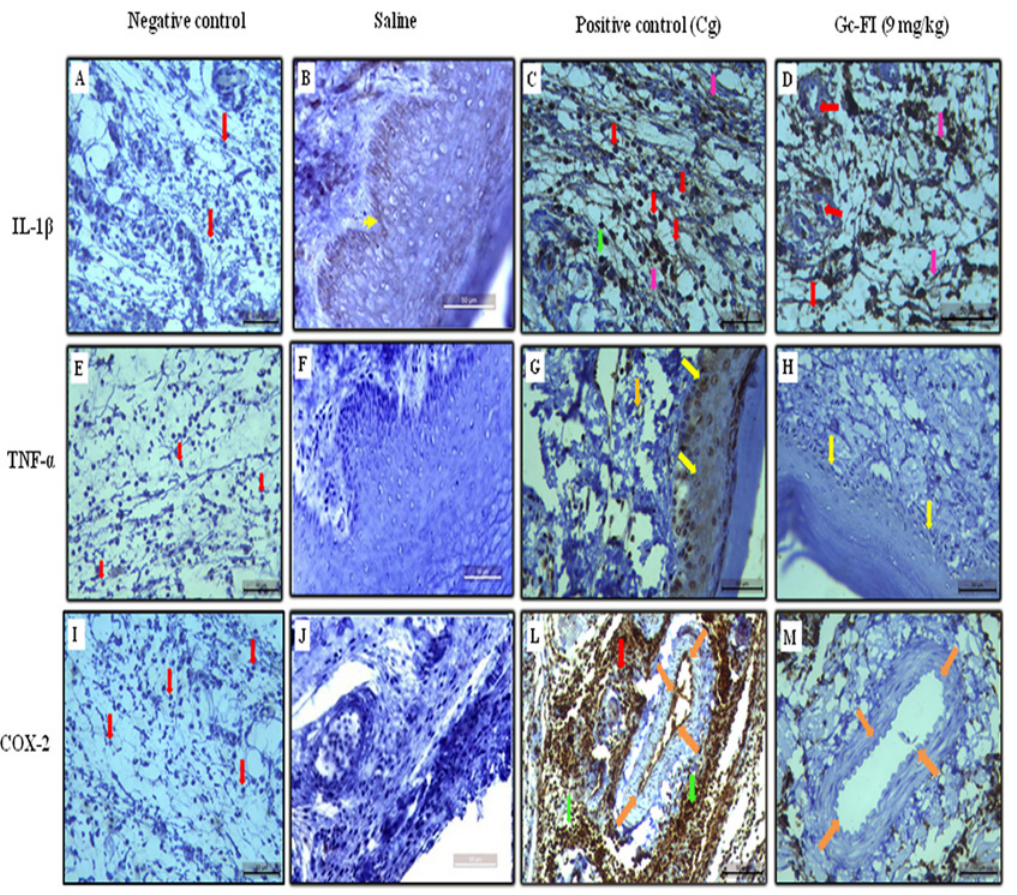
Fig 7. Immunohistochemical staining for IL-1 β , TNF- α and COX-2 expression in paw tissues. Negative control (A, E, I), saline (B, F, J), positive control (C, G, L) and 9 mg/kg Gc-FI (D, H, M). Red arrows: neutrophils. Yellow arrows: epithelium. Green arrows: lymphocyte. Purple arrows: extracellular matrix. Orange arrows: endothelium cell. Scale bar: 50 μ